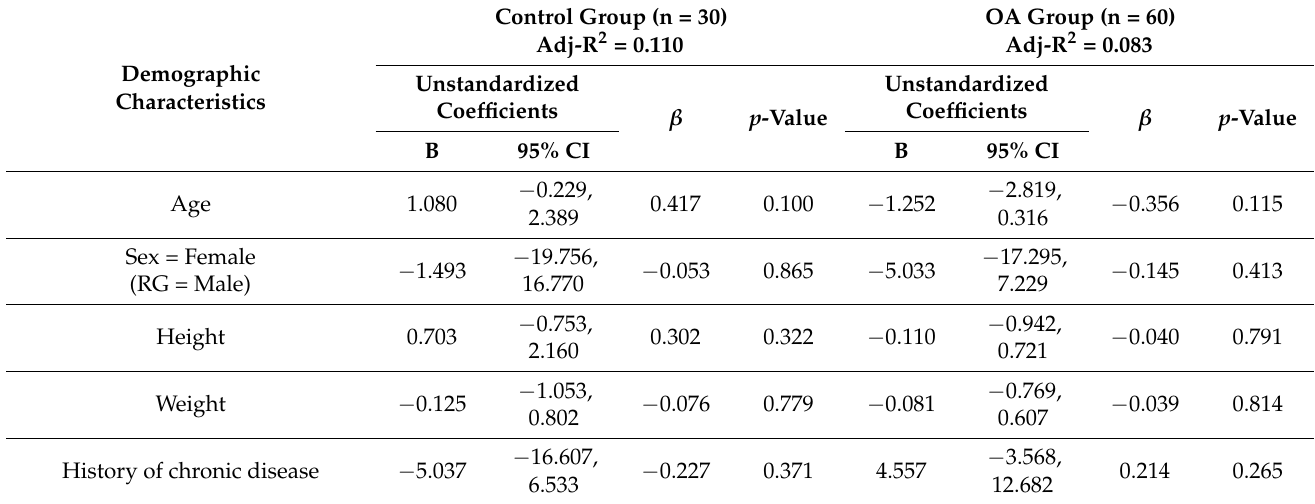
Table 4. Multiple regression analysis between demographic characteristics and physical health component in control and osteoarthritis groups.